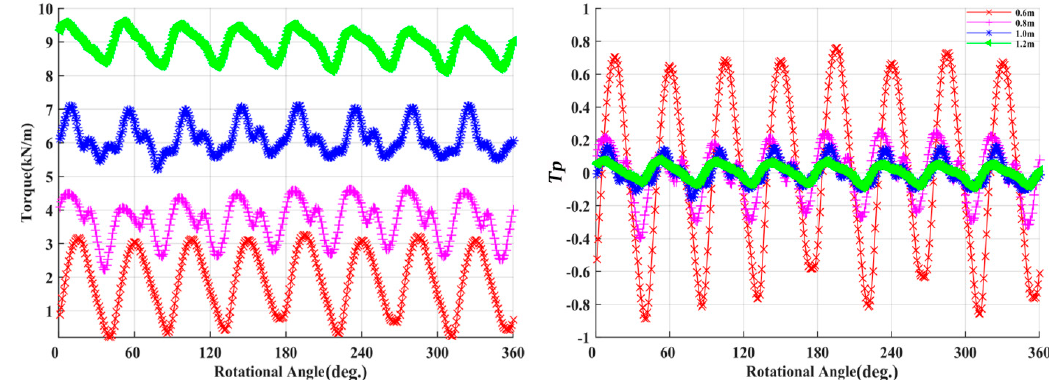
Water 2019 , 11 FOR PEER REVIEW